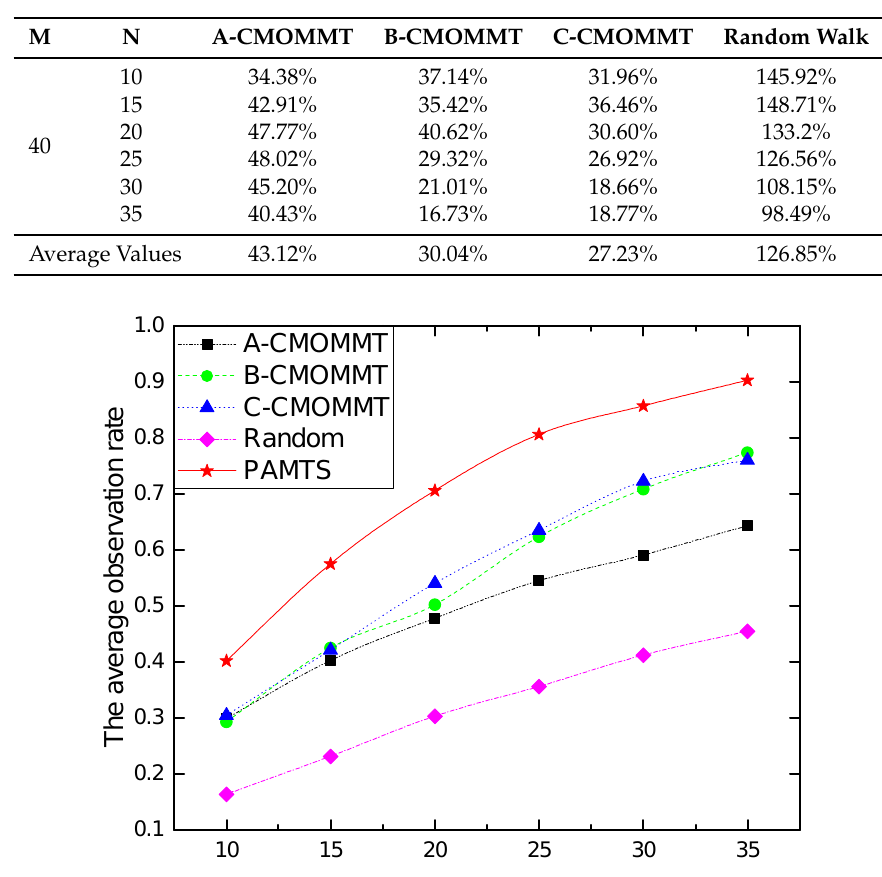
Table 3. The improvement on observation rate of our proposed algorithm over A-CMOMMT, B-CMOMMT, C-CMOMMT and random walk for M = 40, N = 10, 15, 20, 25, 30, 35.